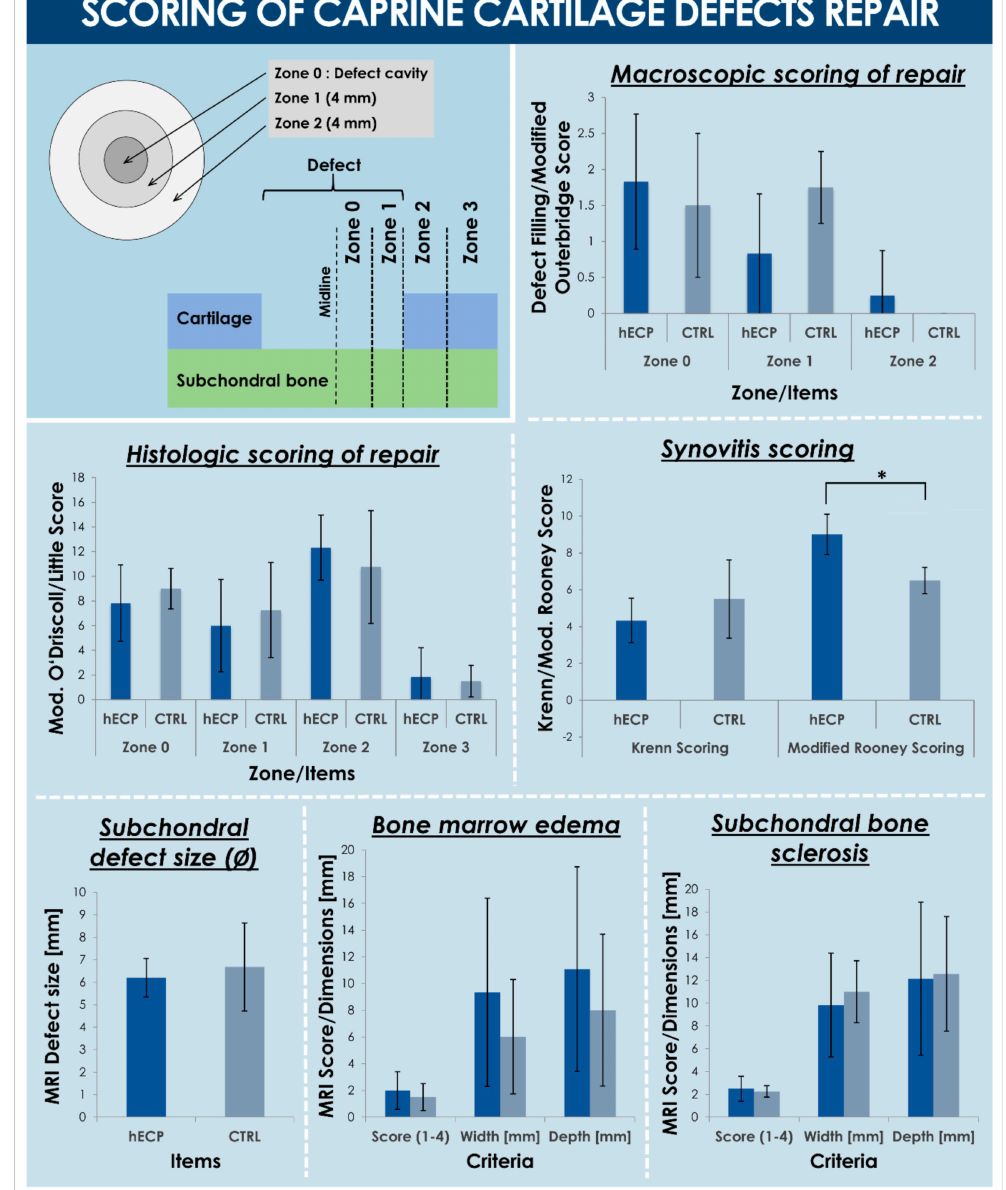
Figure 6. Evaluation and scoring of caprine cartilage repair after three months. The macroscopic state of the defect filling (i.e., Zone 0) was graded, as well as the health of cartilage tissue immediately surrounding the defect zone within 4 mm (i.e., defect rim, Zone 1), the tissue beyond the 4 mm demarcation (i.e., adjacent margin, Zone 2), and the surrounding tissue (i.e., distal margin, Zone 3). Macroscopic repair scoring was performed using the defect filling score and a modified Outerbridge score scale. Histologic scoring of repair was performed using a modified O’Driscoll score scale (i.e., for Zones 0 and 1) and the Little score scale (i.e., for Zones 2 and 3), respectively. Synovitis scoring was performed using the Krenn score scale and a modified Rooney score scale. Measurement and scoring of endpoint defect size, bone marrow edema, and subchondral bone sclerosis were performed based on post-sacrifice MRI data. Data are presented as mean values with standard deviations as error bars. (*) p <